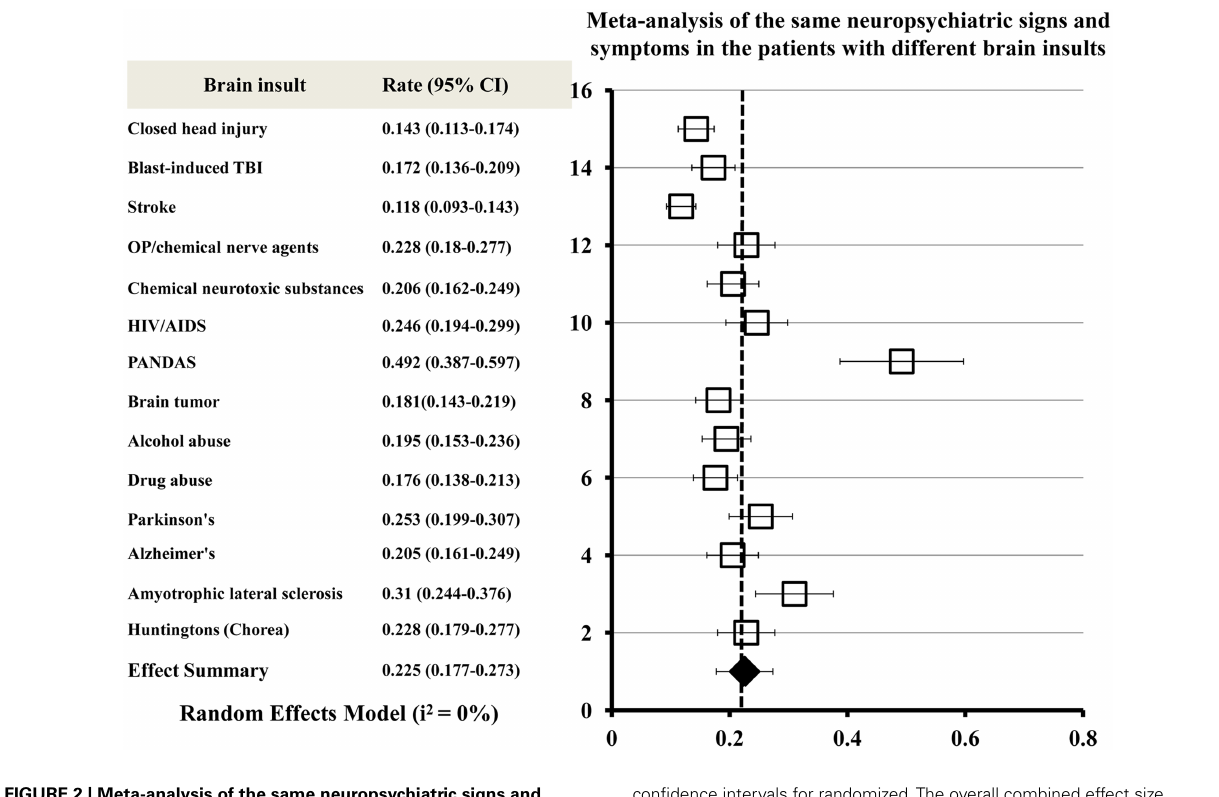
confidence intervals for randomized.The overall combined effect size is indicated by a diamond. Heterogeneity I 2 = 0% for all brain insults